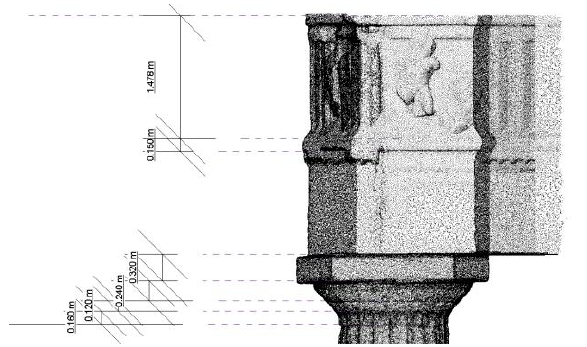
Figure 9. Measuring the column dimensions from the point cloud. (source: Kontoudaki, 2021)